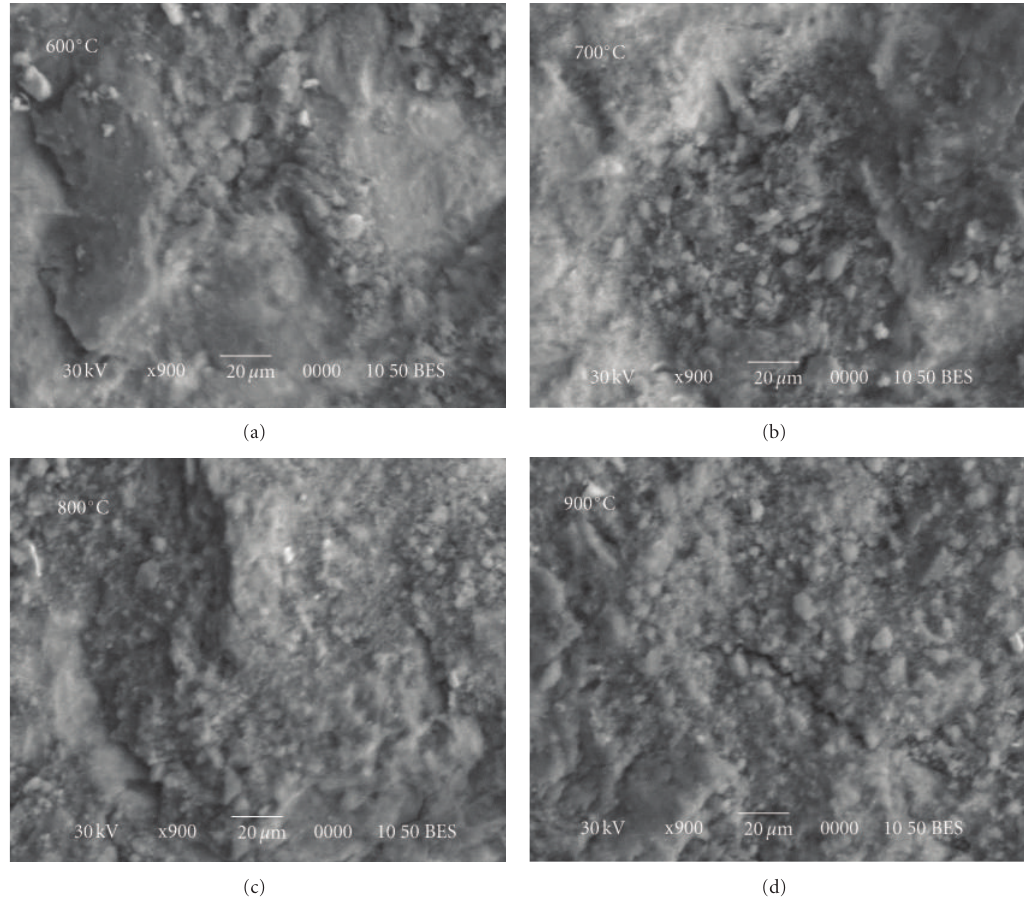
Figure 19: Backscattered electron images of the heat-treated SiHA coating by